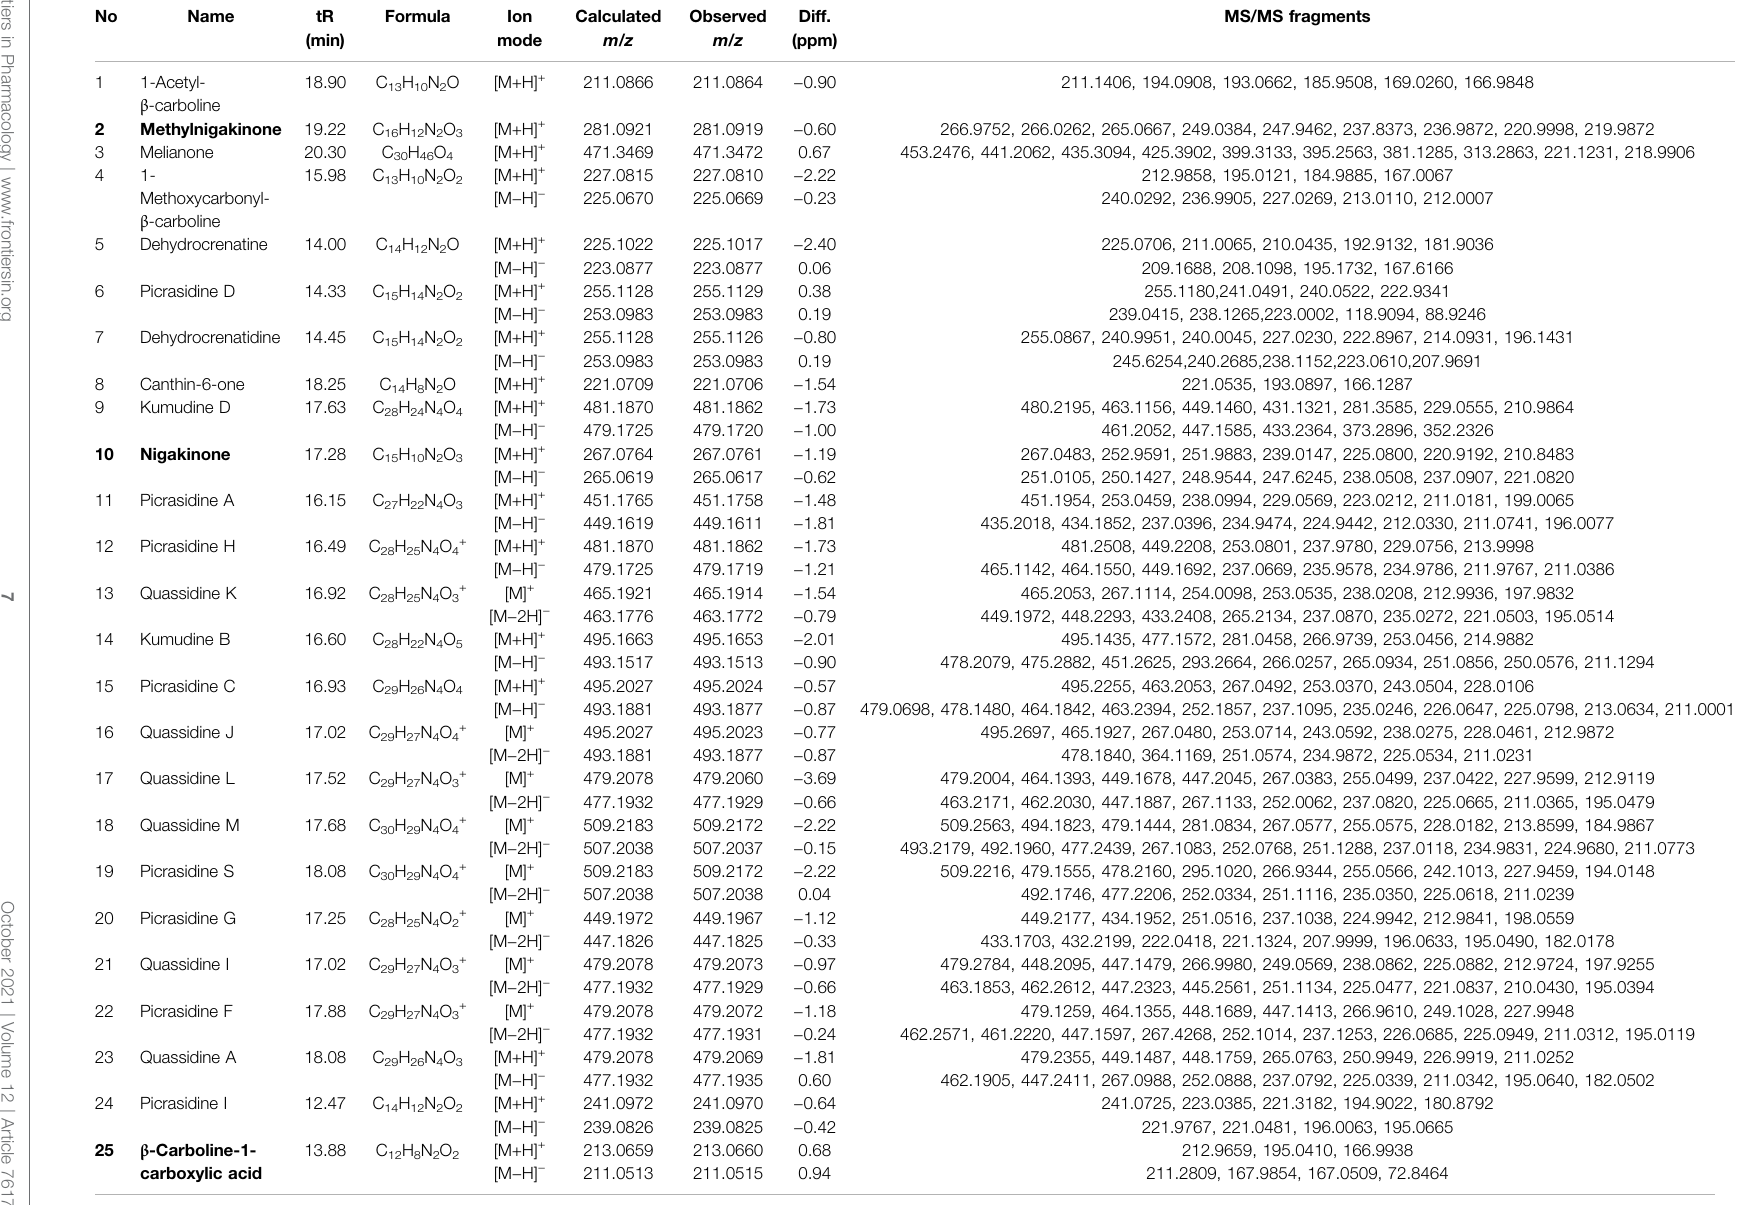
TABLE 2 | Mass information of antimicrobial chemicals identi fi ed from the stem of Picrasma quassioides